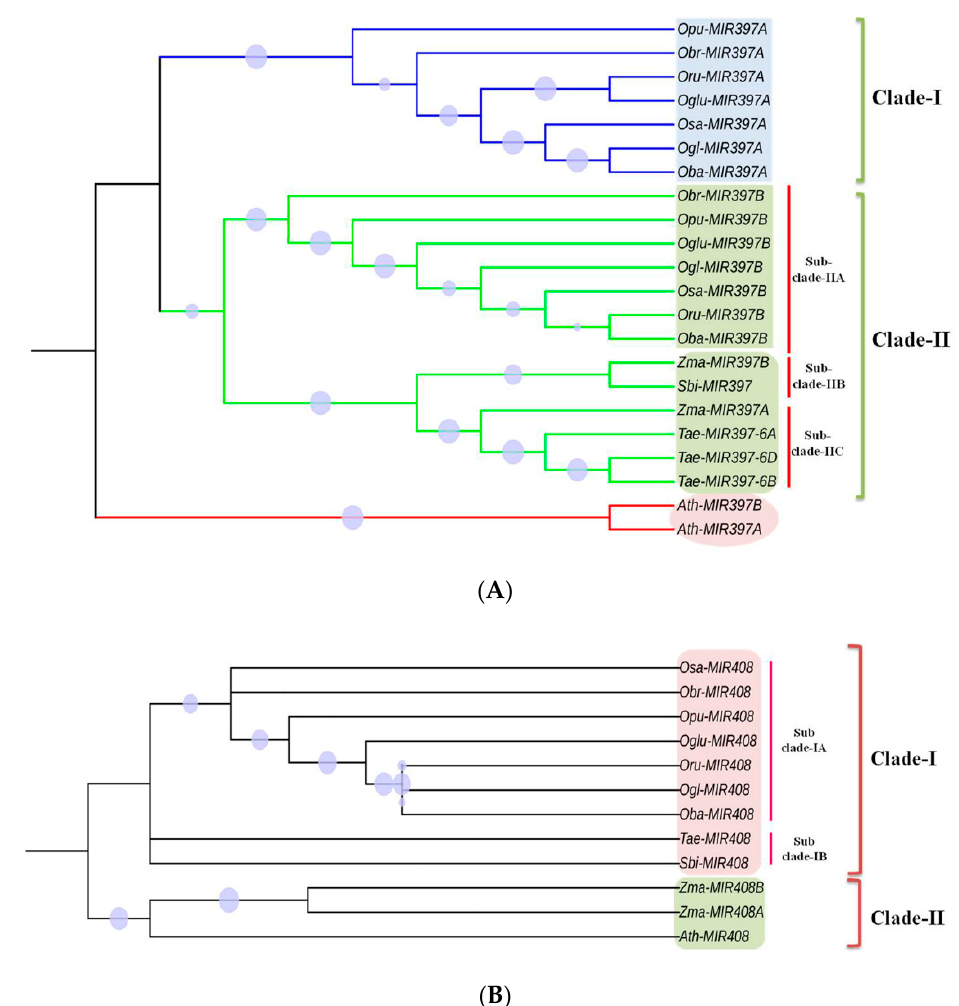
Figure 8. Phylogenetic relationship of MIR397 and MIR408 within poaceae members and Arabidopsis . ( A ) ML phylogenetic tree was constructed for the 22 MIR397 precursor and promoter (500 bp)